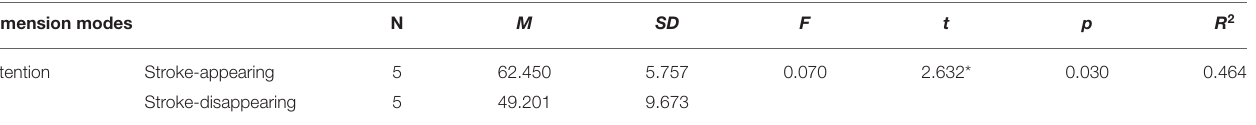
TABLE 2 | Attention levels of the different COS modes. Dimension